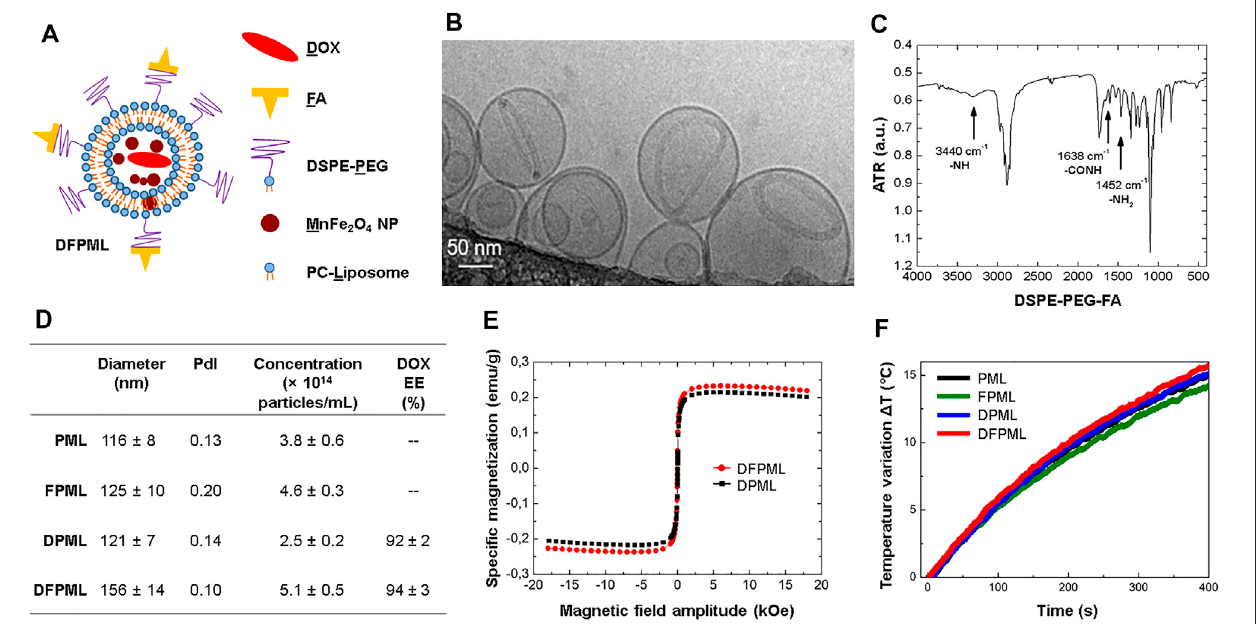
FIGURE 2 | DOX-loaded folate-targeted PEGylated magnetoliposomes (DFPML) characterization. (A) Schematic view of DFPML, with D recalling doxorubicin (DOX); F, folic acid (or the corresponding folate moiety); P, the PEG 2000 composing the DSPE-PEG molecule; M, the MnFe 2 O 4 magnetic NPs; and L, the phosphatidylcholine-based liposome (PC-Liposome). (B) Cryo-TEM representative image ofa non-magnetic aliquot of DFPML (MnFe 2 O 4 NPs absent, emphasis on the water-insoluble DOX salt entrapped within the liposome aqueous core). (C) FTIR spectrum of the synthetic molecule DSPE-PEG-FA, responsible for the folate- targeting property of DFPML. (D) Summary of size and number distribution properties of DFPML (study) and other (control) samples, either not loaded with DOX (PML and FPML) or non-folate-targeted (DPML). DOX encapsulation ef fi ciency (EE, calculated via Eq. 3 ) for DOX-loaded samples (DPML and DFPML). (E) Magnetization pro fi les for DFPML and DPML, from which their magnetic concentrations could be determined via Eq. 1 (4.5 mg/ml and 4.2 mg/ml, respectively). (F) MHT pro fi les used to calculate the SLP values for PML, FPML, DPML, and DFPML. AC magnetic fi eld = 342 Oe, 334 kHz. See Supplementary Table S2 for the corresponding SLP